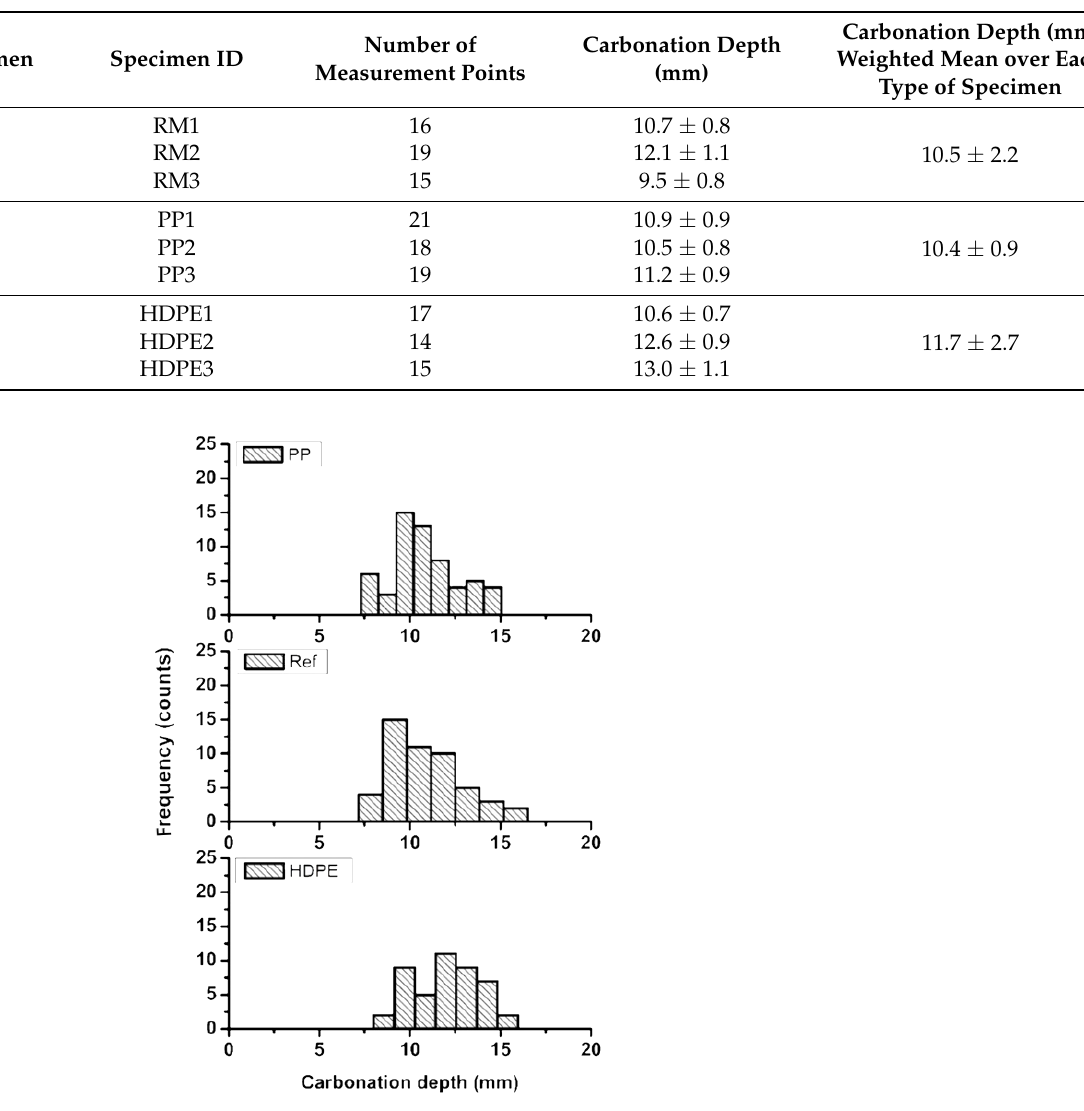
Table 2. Carbonation depth results per specimen and their weighted mean for each type of specimen.